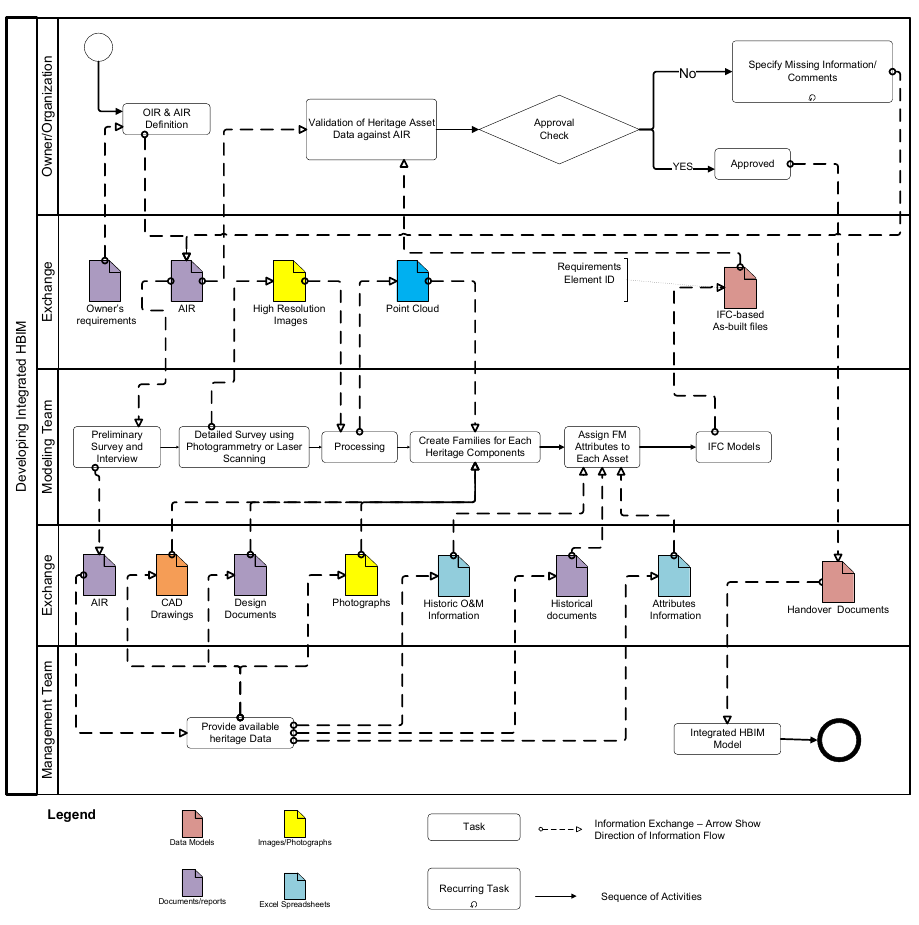
Figure 7. Process map for developing and integrating the heritage BIM model.